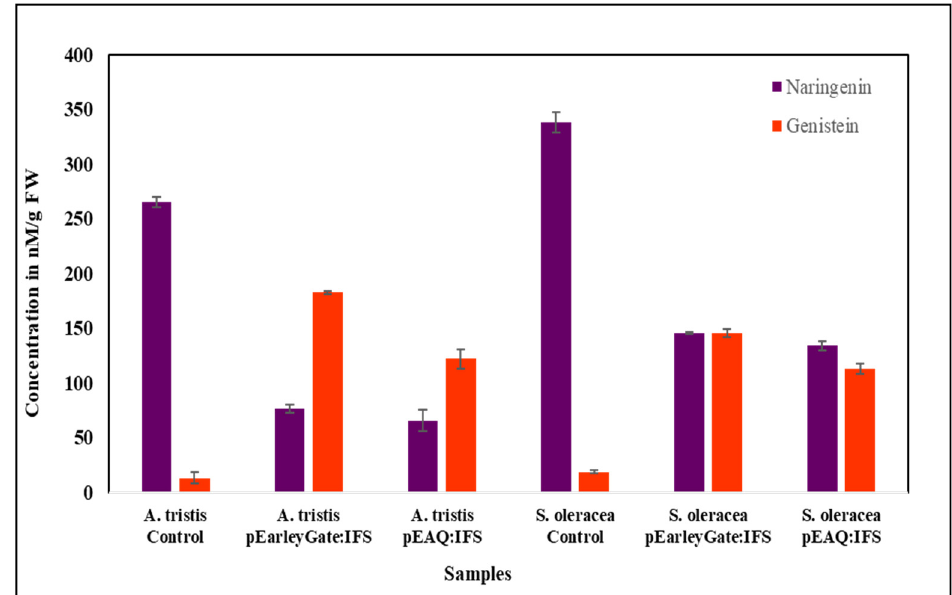
Figure 7. Quantification of naringenin and genistein in control and agroinfiltrated leaf samples